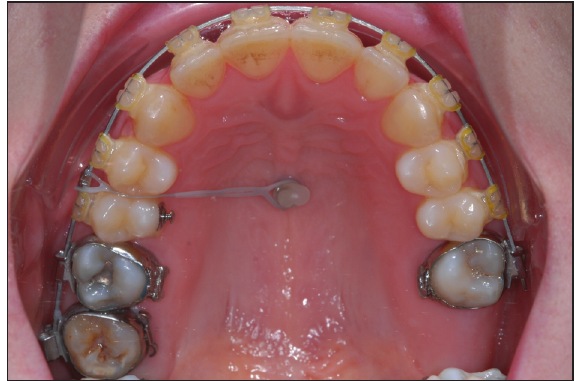
Figure 9. Utilisation of the remaining palatal mini-screw as a source of direct anchorage to achieve transverse arch